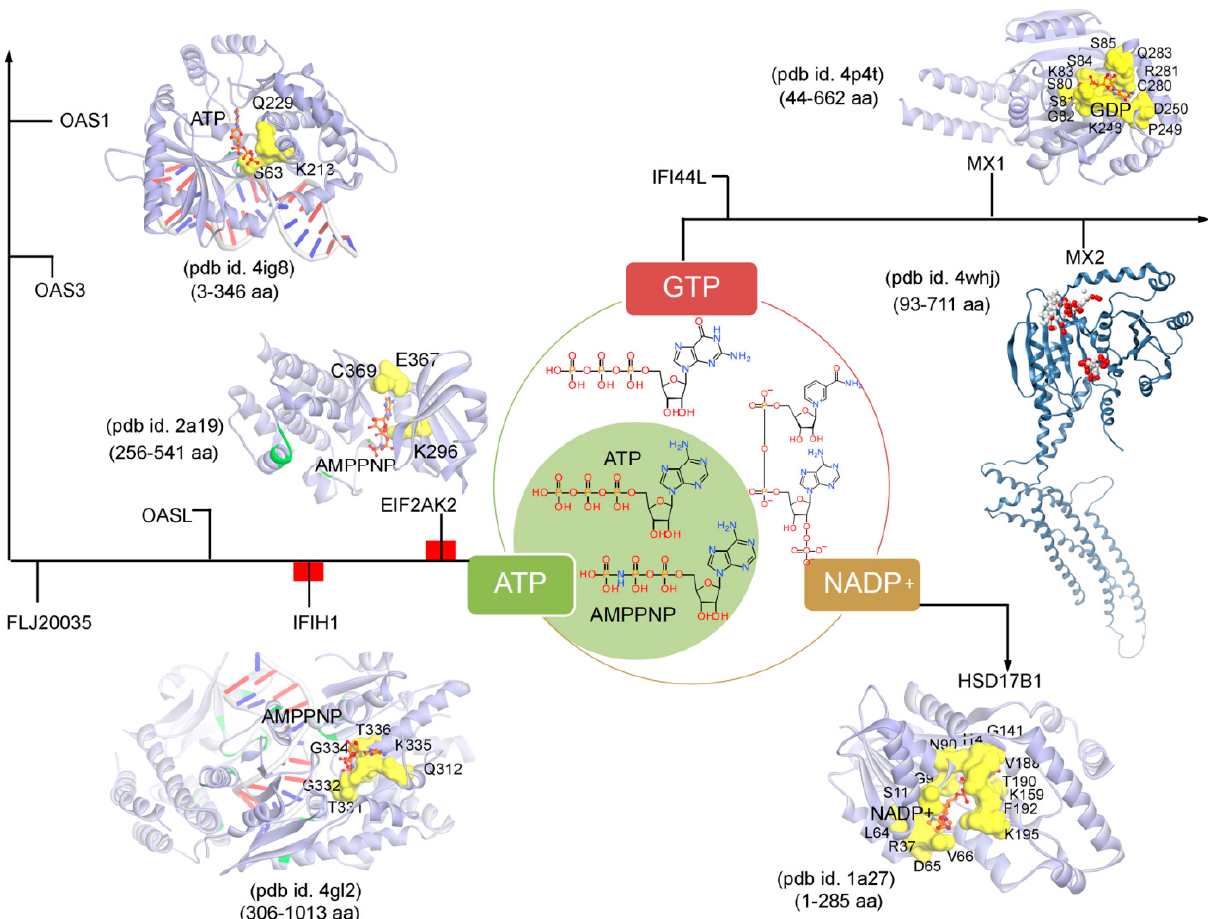
Figure 5. The ATP (adenosine triphosphate), GTP (guanosine triphosphate), or NADP (nicotinamide adenine dinucleotide phosphate) binding residues from a set of IRDS genes. Considering the known tertiary structures from the PDB database [7], the binding sites were defined for the following proteins; OAS1 (pdb id. 4ig8 [100]), EIF2AK2 (pdb id. 2a19 [94]), IFIH1 (pdb id. 4gl2 [96]), MX1 (pdb id. 4p4t [101]), MX2 (pdb id. 4whj [102]), and HSD17B1 (pdb id.1a27 [103]). The ATP, GTP or NADP interfaces were defined considering the amino acids involved in the hydrogen bond (h-bond, distance ≥ 3.5 Å) as well as in the pi-stacking (distance ≥ 5 Å) interactions. The upstream regulators EIF2AK2 and IFIH1 are marked in red label (Figure 3a), differentiating them with the other functional protein. Interacting residues of IRDS genes with its respective partner are presented in yellow surface view, with amino acids labelled in black. The ATP/GTP/NADP and dsRNA structures are coloured in orange and grey, respectively. Particularly for the MX2 gene, the active sites were predicted using the MOE program (Chemical Computing Group Inc., Montreal, QC, Canada), the alpha spheres are presented as either “hydrophobic” or “hydrophilic (for lone pair active; LPA)” in red and white colour. Visualization and representation of the protein tertiary structures for this figure, and tracing hydrogen bonds or pi interactions between two partners was performed using the MOE (Chemical Computing Group Inc., Montreal, QC, Canada) and BIOVIA Discovery Studio Visualizer (Dassault Systèmes, BIOVIA, San Diego, CA, USA) programs.